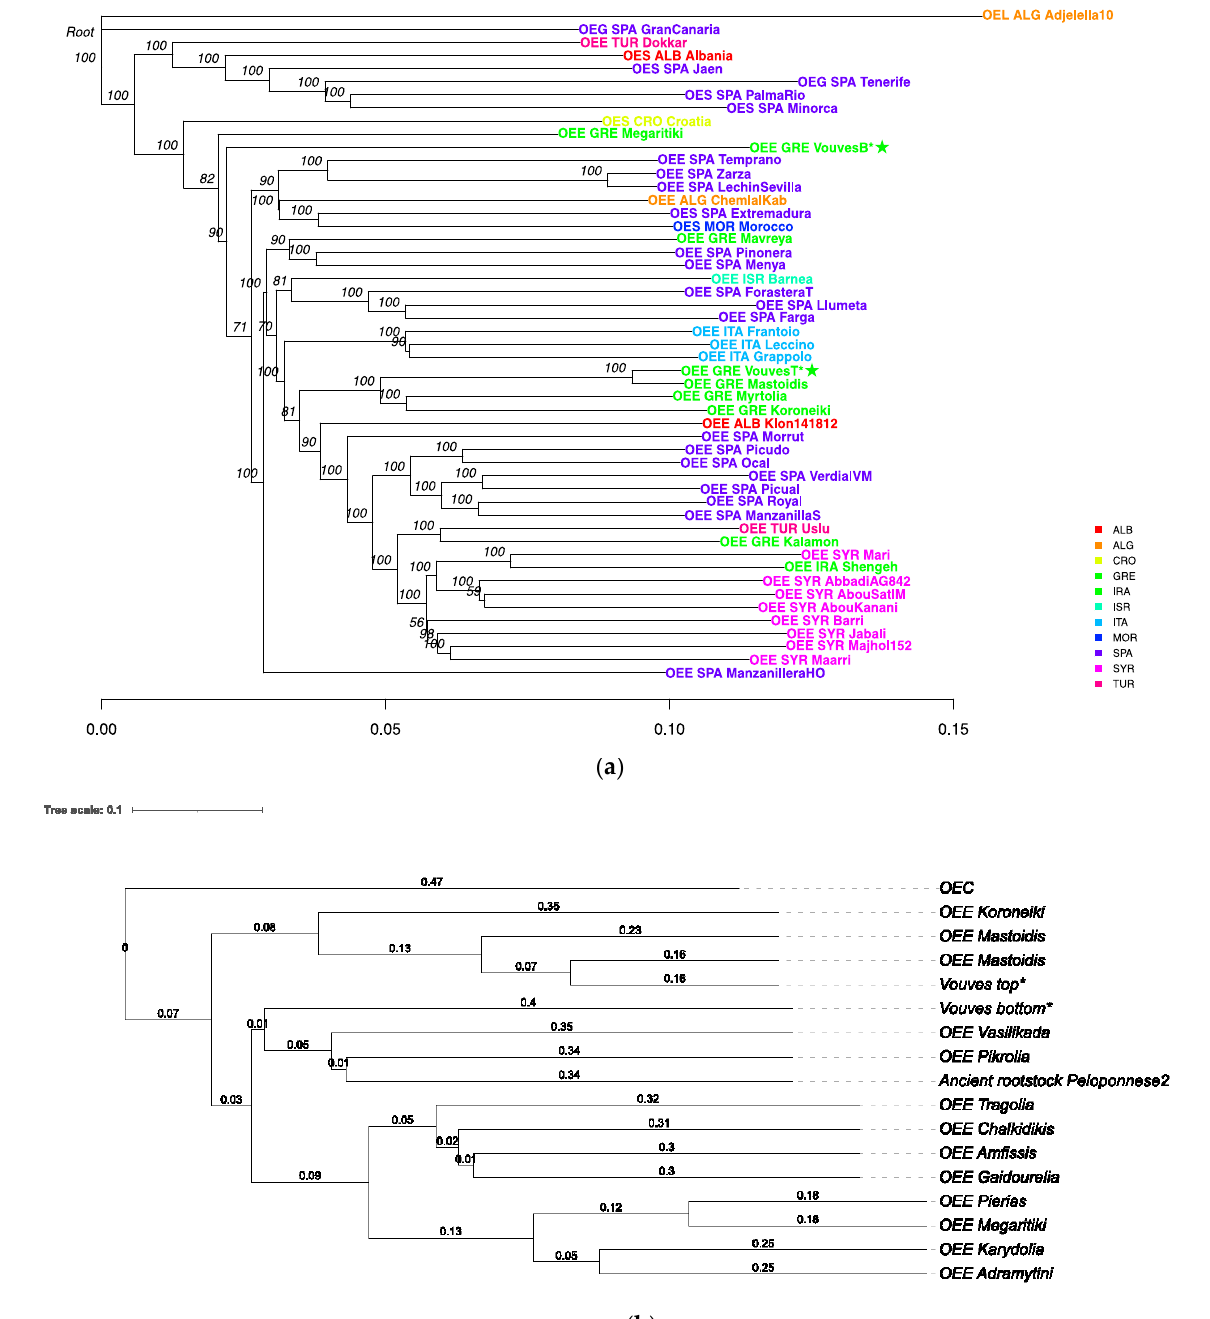
Figure 2. ( a ) Phylogenomic NJ tree made with the 71,040 filtered biallelic SNPs produced with whole genome resequencing data. Taxa names encode the subspecies (OEL, for Olea europaea subsp. laperrinei ; OEG, Olea europaea subsp. guanchica ; OES, Olea europaea var. sylvestris and OEE, Olea europaea subsp. europaea ), country of origin, also with different colors [ALB (red), Albania; ALG (orange), Algeria; CRO (yellow), Croatia; GRE (light green), Greece; IRA (green), Iran; ISR (green-blue), Israel; ITA (light blue), Italy; MOR (blue), Morocco; SPA (purple), Spain; SYR (light purple), Syria and TUR (pink), Turkey] and variety name ( n = 51). Bootstrap values are in cursive over their respective nodes. Target samples (Vouves Bottom and Top) have been marked with an asterisk ( b ) UPGMA similarity dendrogram of 12 present-day Greek cvs, the two Vouves samples and one “ancient” olive-tree genotype based on Jaccard’s index ( n = 16). Distances based on Jaccard's index are indicated on each branch of the tree. Olea europaea subsp. c uspidata (Wall. and G. Don) Cif. (denoted as OEC) was employed as an outgroup. Other taxa names correspond to the Olea europaea subsp. europaea (OEE) cvs (data from [36] reprocessed within the framework of present study). Distances are indicated above each tree branch.